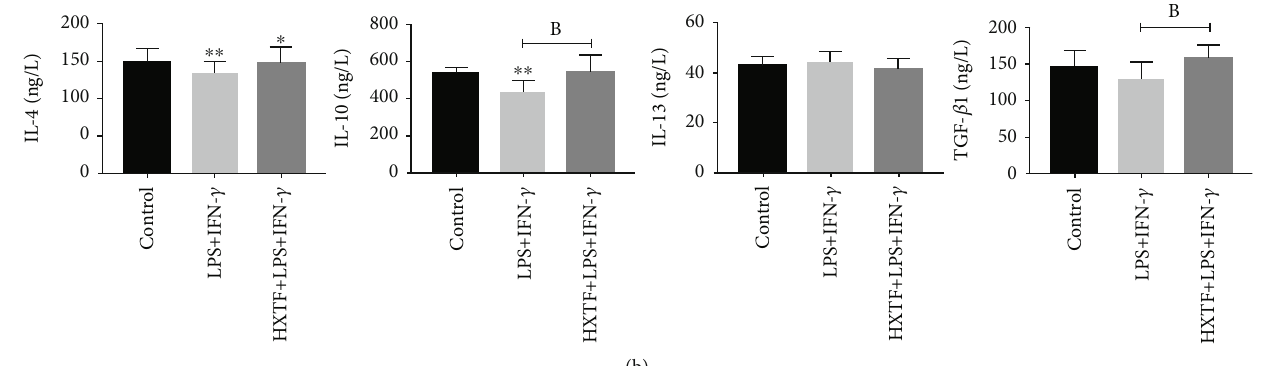
Figure 3: E ff ect of HuoXueTongFu Formula (HXTF) on M1 polarization induced by LPS+IFN- γ . RAW264.7 macrophages were incubated during 12h with the control DMEM solution and LPS+IFN- γ , respectively. Meanwhile, RAW264.7 cells were preincubated with LPS+IFN- γ for 3 h, followed by combined treatment with HXTF for 12 h. (a) Flow cytometry analysis of M1/M2 marker CD86 and CD206 expression. (b) ELISA analysis of M1/M2 gene marker expression on macrophages. All values are expressed as mean ± S : E : ( n = 3 experiments). ∗ p < 0 : 05 , ∗∗ p < 0 : 01 , a p < 0 : 05 , and b p < 0 : 01 , comparison of the designated two